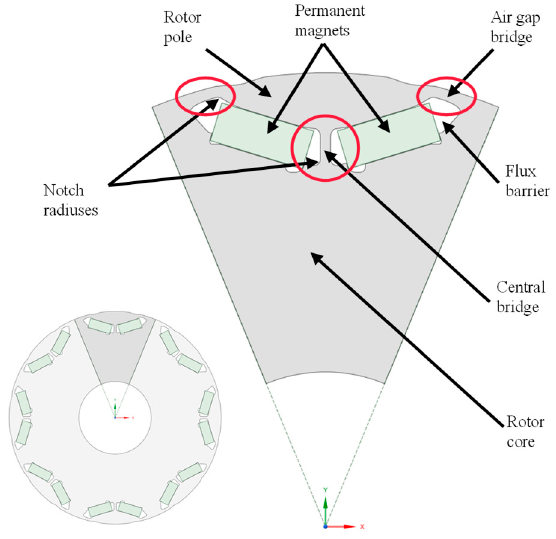
Figure 2. Definition of a single-pole rotor geometry definition marked areas where MMS can occur.